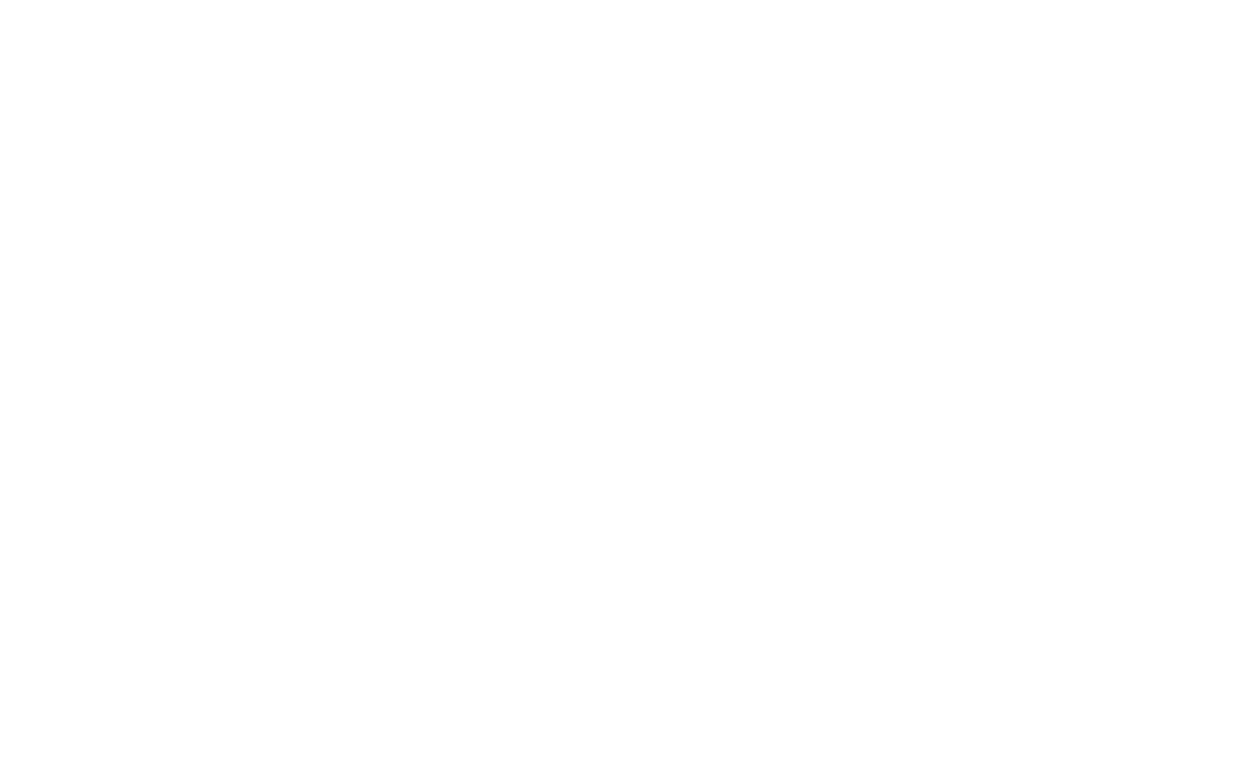
Frontiers in Pharmacology |